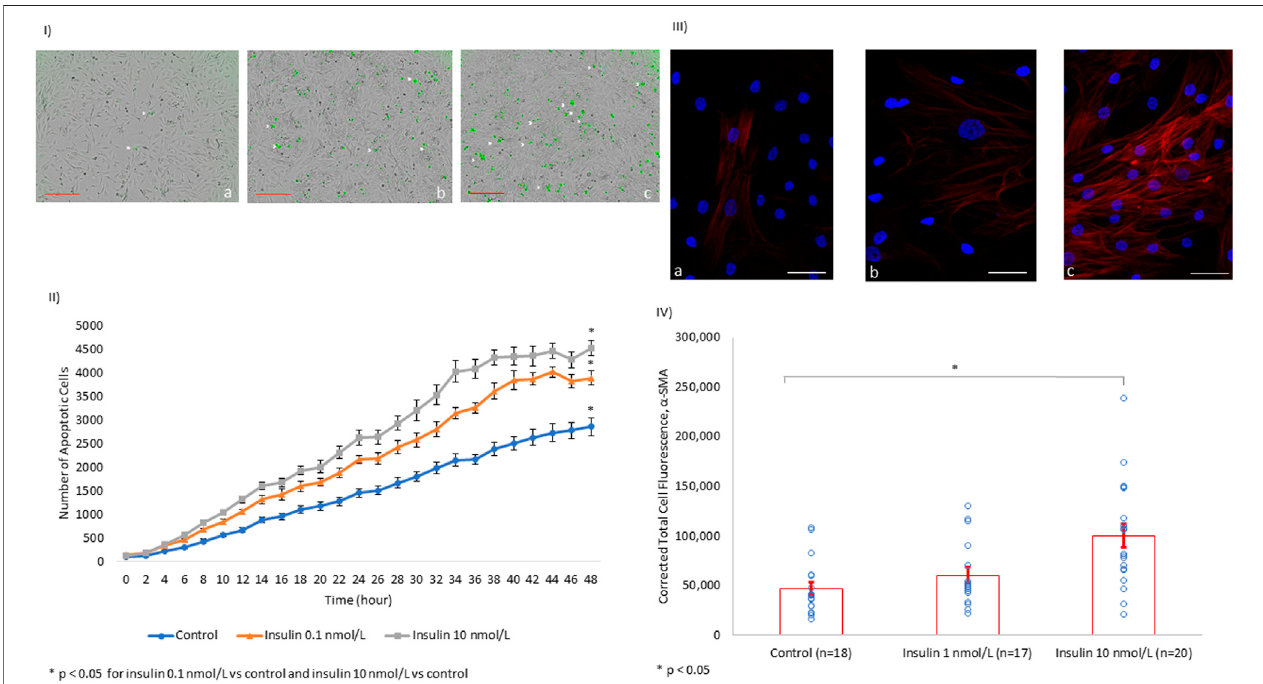
FIGURE 3 | In vitro , Insulin Induces Cardiomyocyte Apoptosis and Myo fi broblast α -SMA Expression in a Dose-dependent Manner. (I) Images of human cardiomyocytes (AC16) after 48 h of incubation with tissue culture media alone (a), tissue culture media + insulin 0.1 nmol/L (b), and tissue culture media + insulin 10 nmol/L (c). The number of apoptotic cells (white arrowhead) increases with the increasing concentration of insulin (scale bar: 300 µm). (II) Line chart quantifying the trend ofapoptosis in human cardiomyocyte AC16 cultures over 48 h under different insulin concentrations. (III) HCF are shown with the nucleus (blue) and α -SMA (red)atbaselineamongcontrols(a).Thereisnosigni fi cantdifferencein α -SMAexpressioninHFCtreatedwithinsulinat1 nmol/L(b).However,thelevelsof α -SMAalmost doubled with insulin treatment at 10 nmol/L (c, scale bar: 50 µm). (IV) Quanti fi cation of the α -SMA expression level using immuno fl